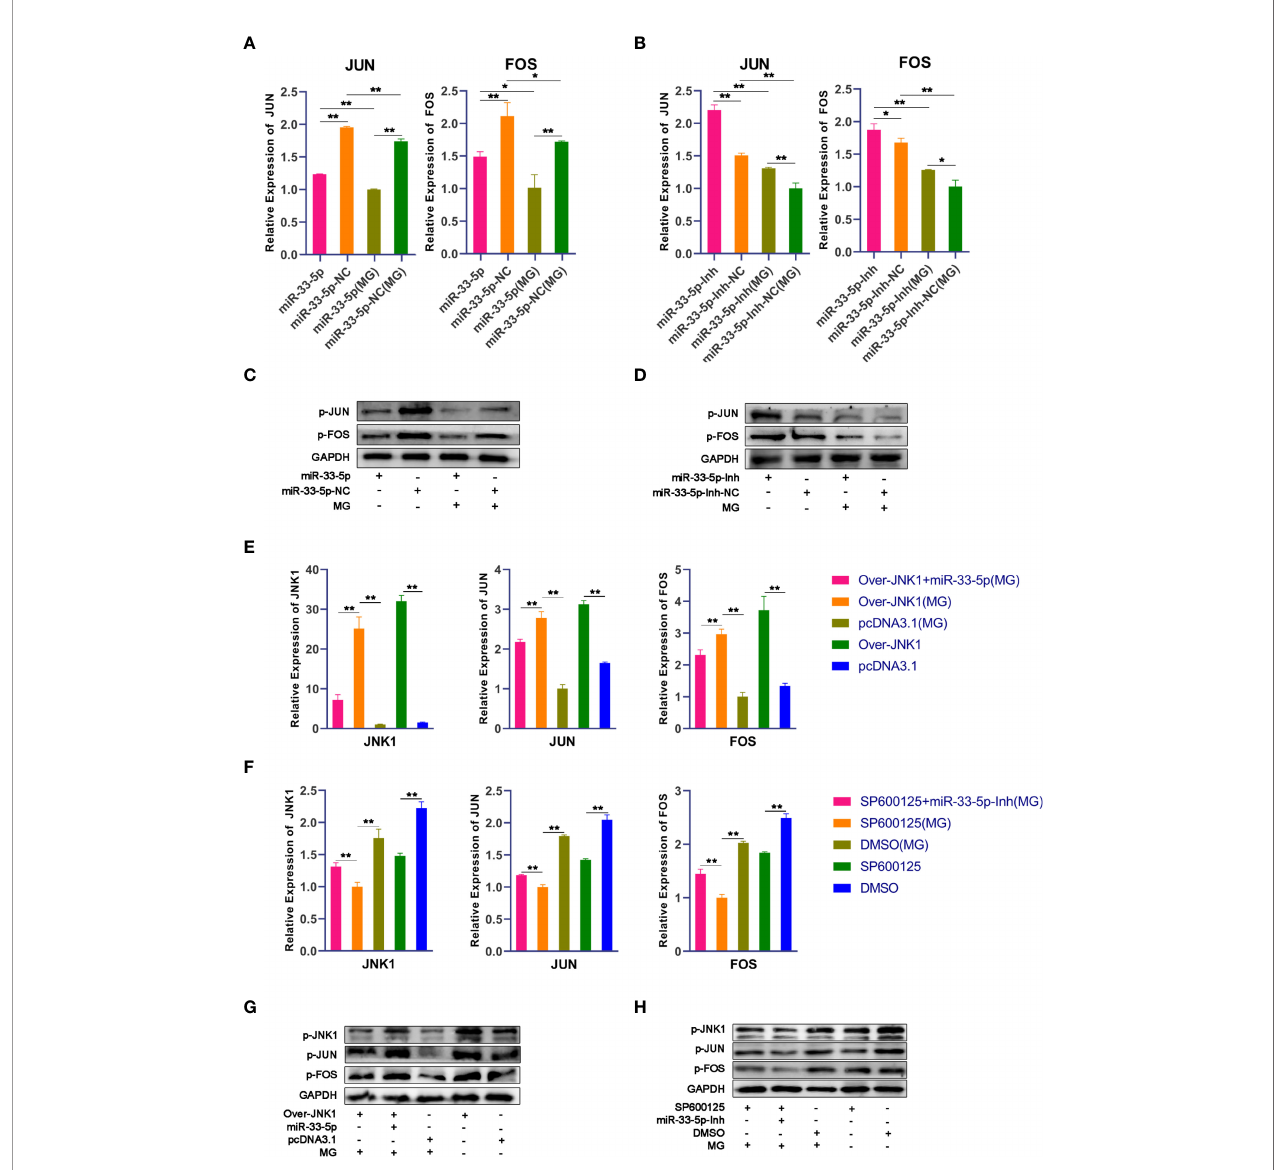
FIGURE 5 | miR-33-5p suppresses the JNK pathway by directly inhibiting the expression of JNK1. DF-1 cells were transfected with the indicated RNA oligonucleotides and infected with MG. JNK1, JUN and FOS mRNA levels and protein levels were measured by qPCR and Western blotting, respectively. (A) The relative mRNA expression level of JNU and FOS after treatment with miR-33-5p mimics; (B) The relative mRNA expression level of JNU and FOS after treatment with miR-33-5p inhibitor; (C) The protein expression of JNU and FOS after treatment with miR-33-5p mimics; (D) The protein expression of JNU and FOS after treatment with miR-33-5p inhibitor; (E) The relative mRNA expression level of JNK1, JUN and FOS after co-transfection of overexpression JNK1 vector and miR-33-5p mimics; (F) The relative mRNA expression level of JNK1, JUN and FOS after co-transformation of SP600125 and miR-33-5p inhibitor; (G) The protein expression of JNK1, JUN and FOS after co-transfection of overexpression JNK1 vector and miR-33-5p mimics; (H) The protein expression of JNK1, JUN and FOS after co- transformation of SP600125 and miR-33-5p inhibitor. GAPDH was used as the internal control. (* p < 0.05, ** p <